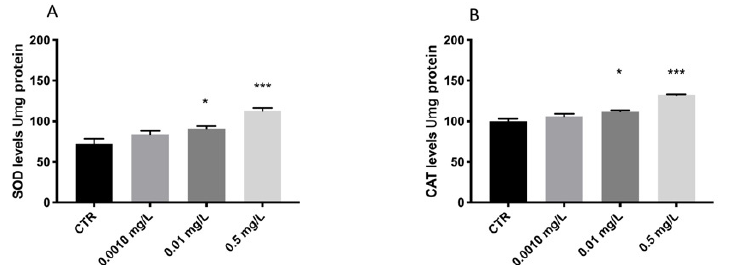
Figure 2. Effects of OXA exposure on activities of SOD ( A ) and CAT ( B ), in the larval zebrafish. Embryonic zebrafish was exposed to OXA for 96 hpf. Data are expressed as the mean ± SEM of three replicates (about 10 larvae per replicate). The asterisk denotes a statistically significant difference when compared with the CTRL: * p < 0.05, *** p < 0.001 versus control.